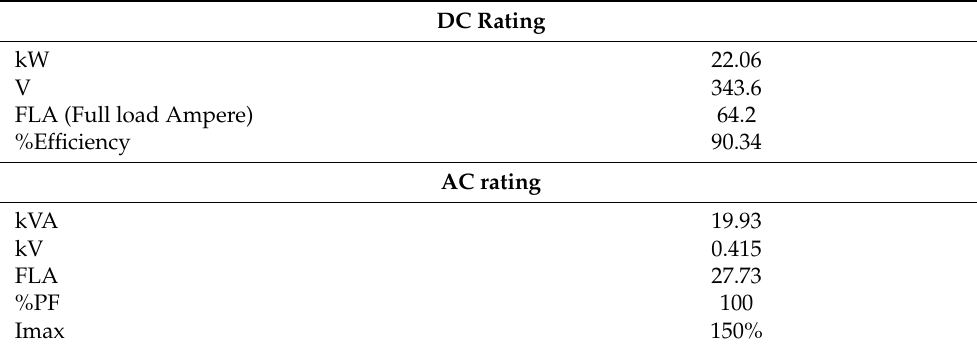
Table 5. Data for three-phase inverter unit for solar PV system obtained from ETAP